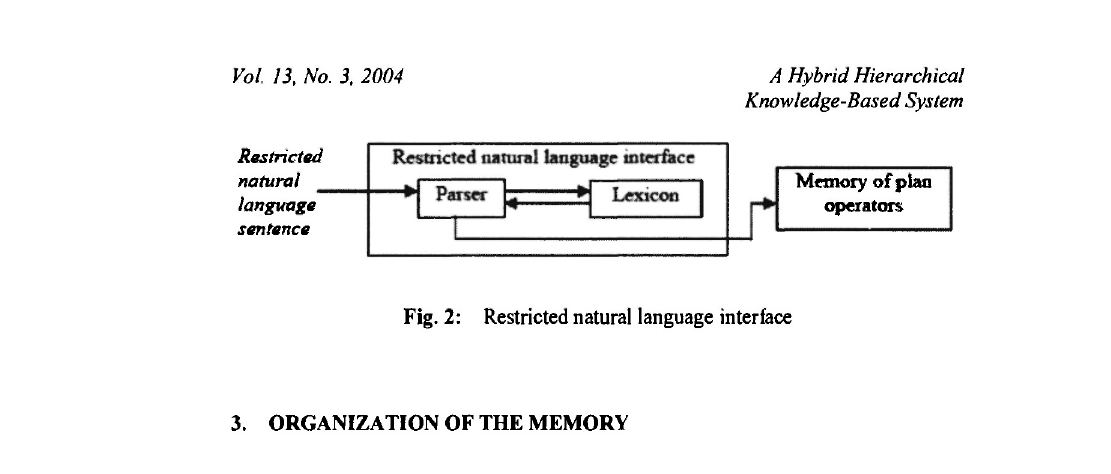
Fig. 2: Restricted natural language